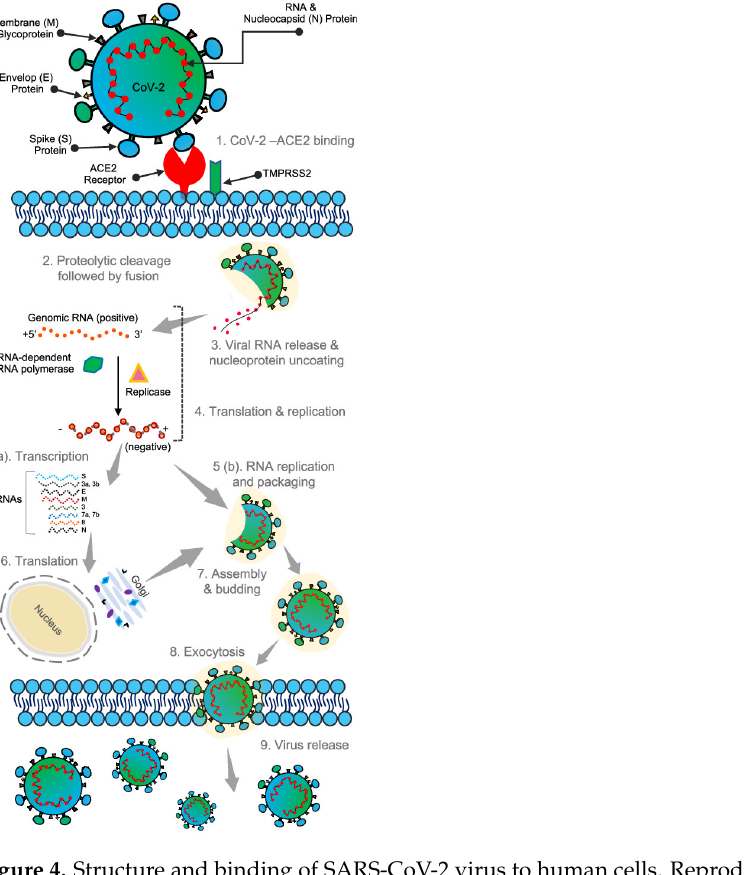
Figure 4. Structure and binding of SARS-CoV-2 virus to human cells. Reproduced with permission from [20], Creative Commons.